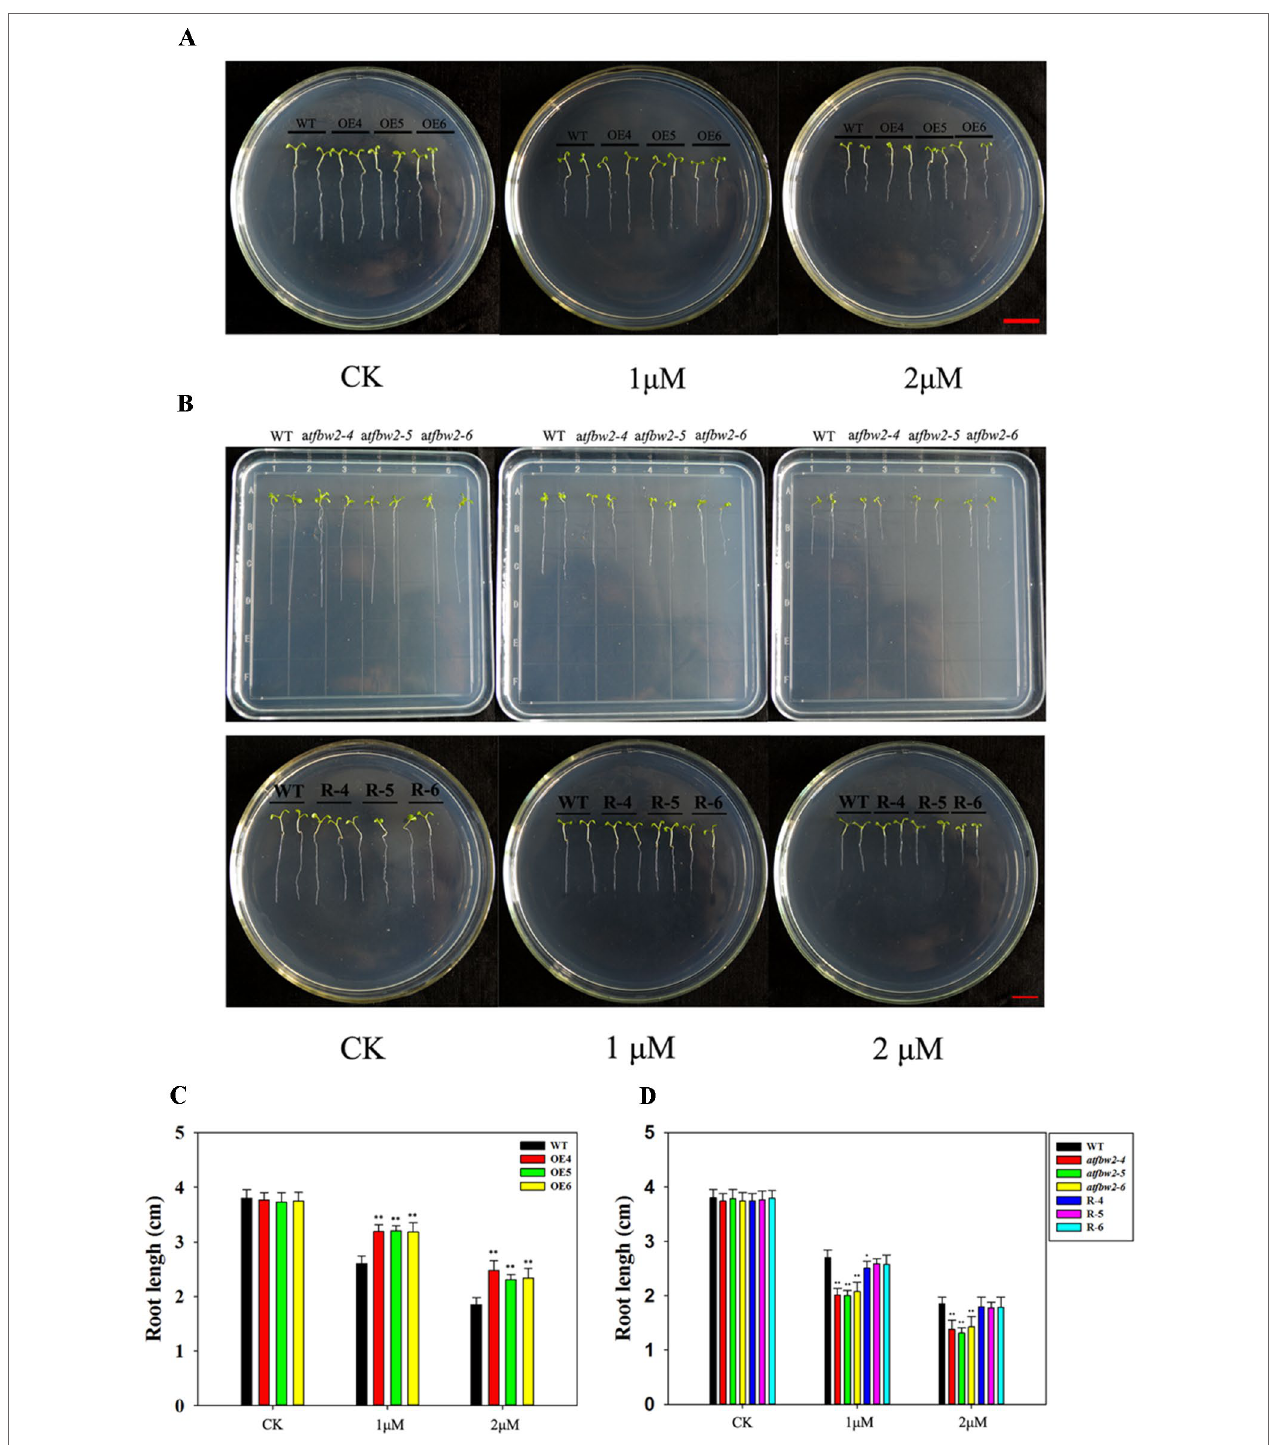
FIGURE 6 | Root growth of Arabidopsis plants following ABA treatment. (A) Root growth phenotype and (C) root length statistics of WT and TaFBA1 overexpressing lines (OE4, OE5, OE6). (B) Root growth phenotype and (D) root length statistics of WT, mutant ( atfbw2-4 , atfbw2-5 , atfbw2-6 ), and recovery plants (R-4, R-5, R-6). Root lengths were measured 5 days after transfer of 3-day-old seedlings from MS medium to plates with or without ABA. Data represent the mean ± SE of three biological replicates. * P < 0.05; ** P <